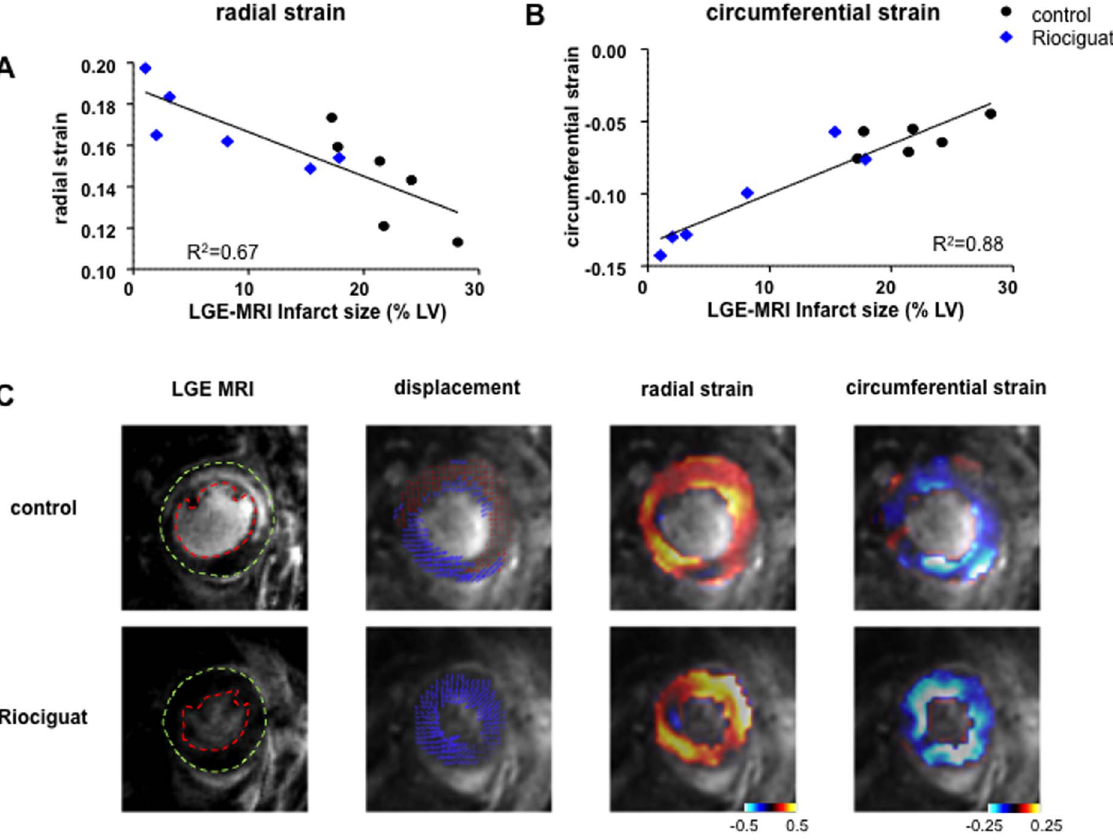
Figure 5. Assessment of cardiac deformation after myocardial infarction. Radial ( A ) and circumferential ( B ) strain as representative markers of heart deformation were obtained 24 h after infarct with LGE-MRI Both parameter show marked improvement in heart function after treatment with riociguat (blue) compared to untreated control (black). Representative images are also shown for each of the parameters. Endocardial and epicardial borders have been delineated on the LGE images, hypokinetic areas have been marked in red in the displacement images.